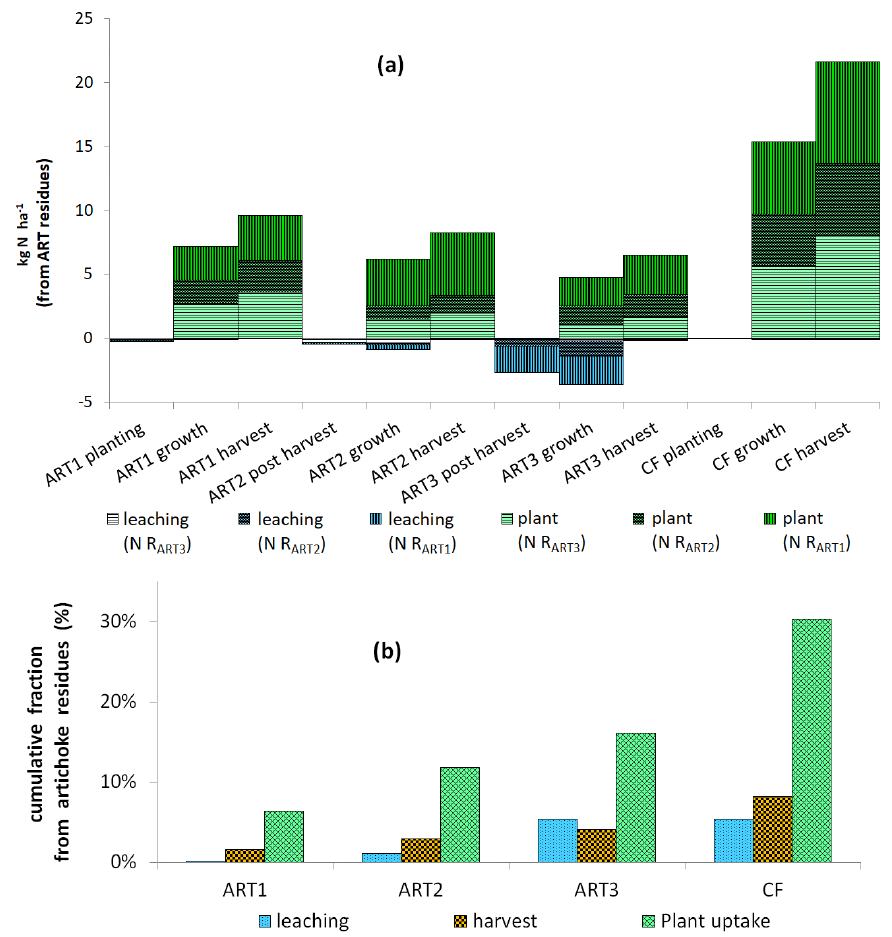
Figure 3. Nitrogen taken from artichoke (ART) residues: ( a ) distribution of R ART1 , R ART2 and R ART3 in plant and leaching; and ( b ) cumulative nitrogen from ART residues in leaching, harvest and total plant uptake of ART and cauliflower (CF) crops. R ART1 , R ART2 and R ART3 correspond to the artichoke residues chopped and applied to the soil after the first, second and third harvests, respectively.